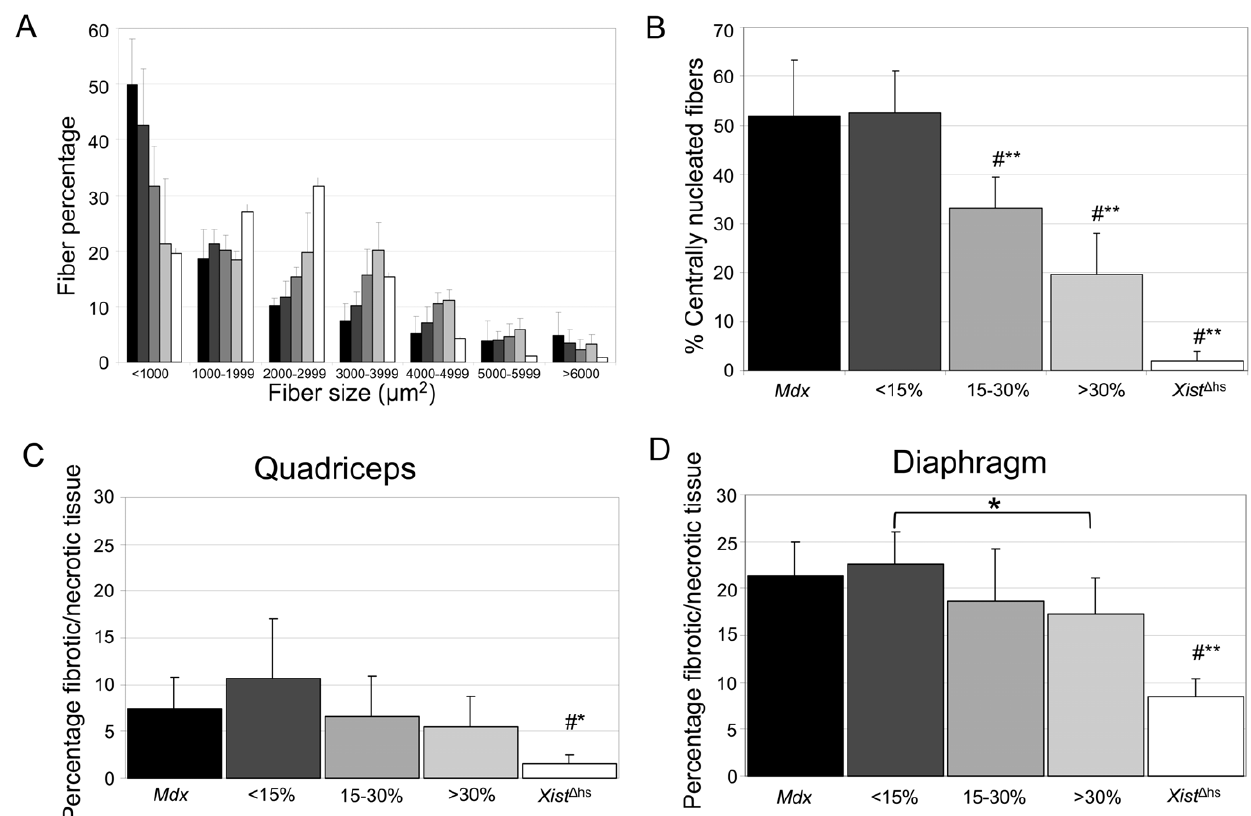
Figure 3. Muscle fiber size, degree of central nucleation and percentage of fibrotic/necrotic tissue. A. Regenerating and hypertrophic fibers were mainly observed in the mdx mice. A dystrophin level depend trend towards wild type distribution was observed for mdx-Xist D hs mice where , 15% dystrophin already resulted in improvement. B. Dystrophin levels between 15–30% and . 30% resulted in a reduction of the percentage of centralized nuclei of 40% and 60% respectively. C. The quadriceps of all mice was significantly more severely affected compared to Xist D hs mice. D. The diaphragm was the most severely affected muscle with on average 20% fibrotic/necrotic tissue in mdx mice. All mice were significantly more severely affected compared to Xist D hs mice. Mdx-Xist D hs mice with . 30% dystrophin had less fibrotic/necrotic tissue than mdx and mdx-Xist D hs mice with , 15% dystrophin, but this difference was only significant between both mdx-Xist D hs groups. # indicates a significant difference of that bar with all the other groups. Single asterisks indicate a P , 0.05 and double asterisks indicate a P ,